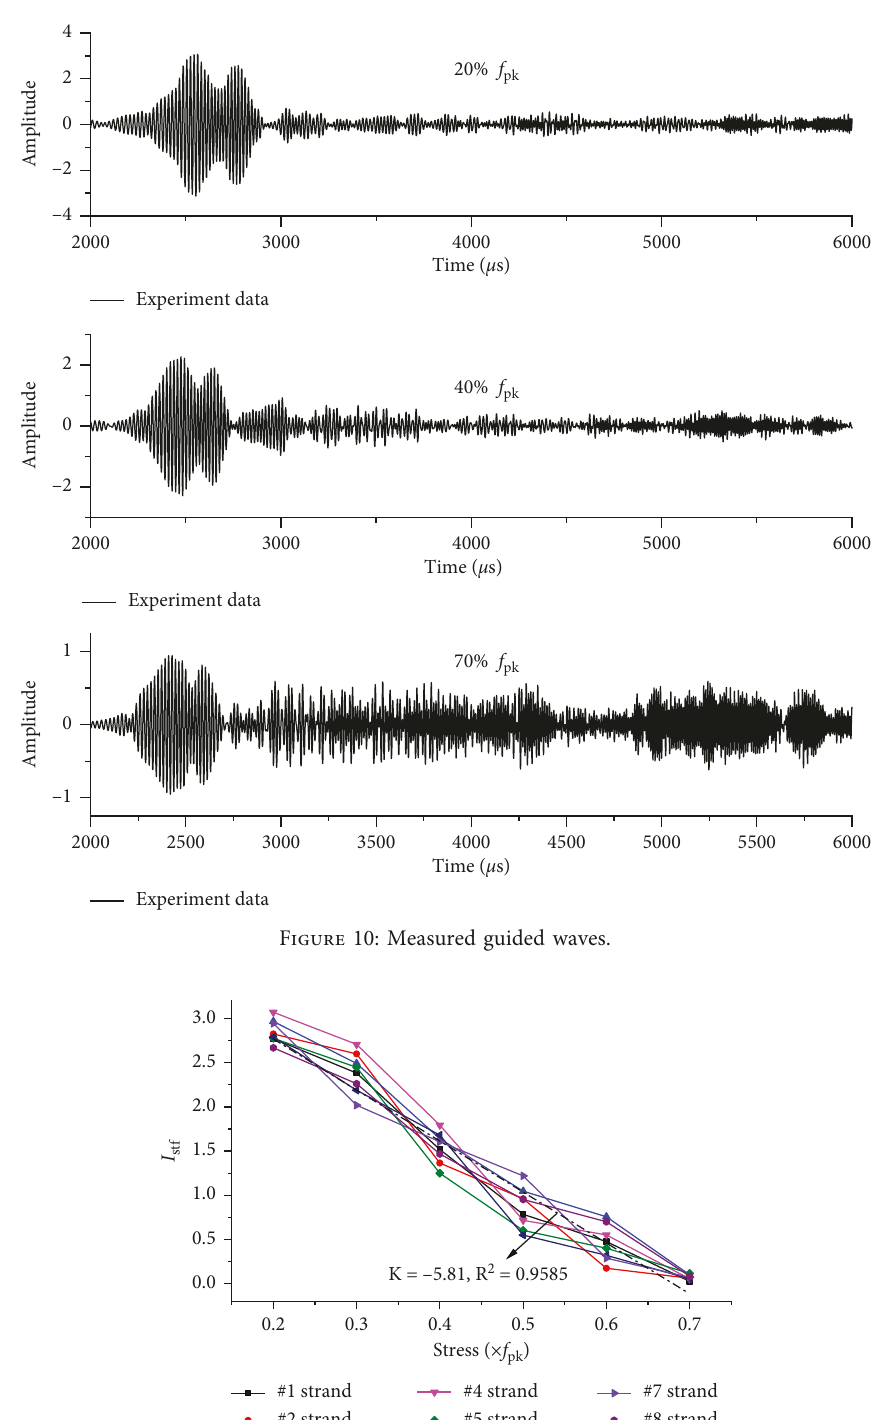
Figure 11: Relationship curves between the recognition index and tensile force.